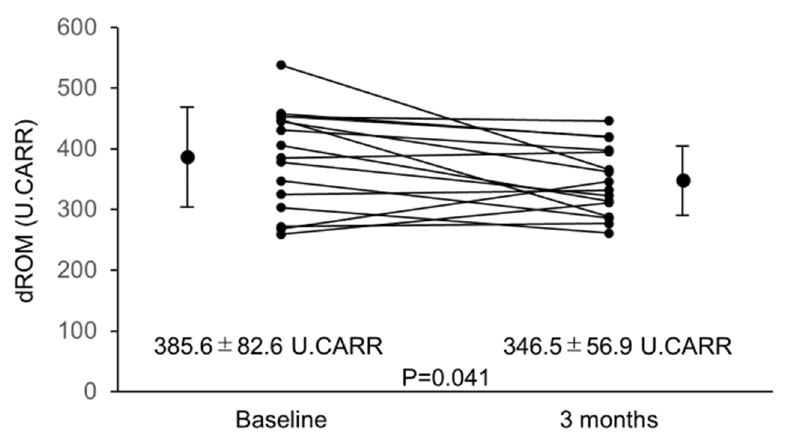
Figure 1. Changes in dROM from baseline to 3 months. dROM decreased significantly from baseline to 3 months after starting astaxanthin supplementation. Abbreviations: dROM, diacron reactive oxygen metabolites.